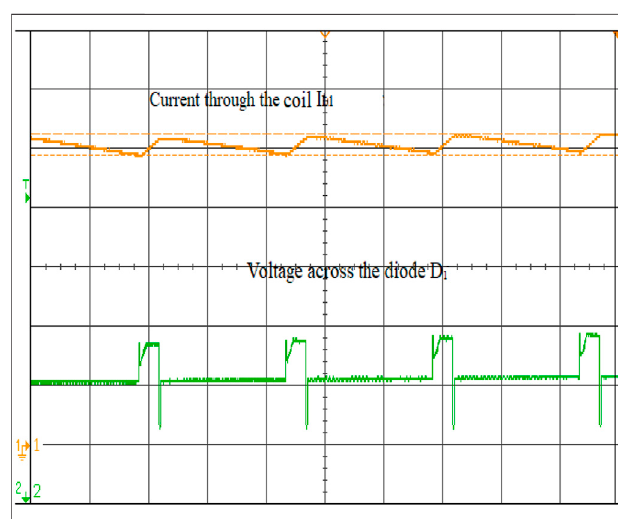
FIGURE 10 | Characteristics of switch S 2 .